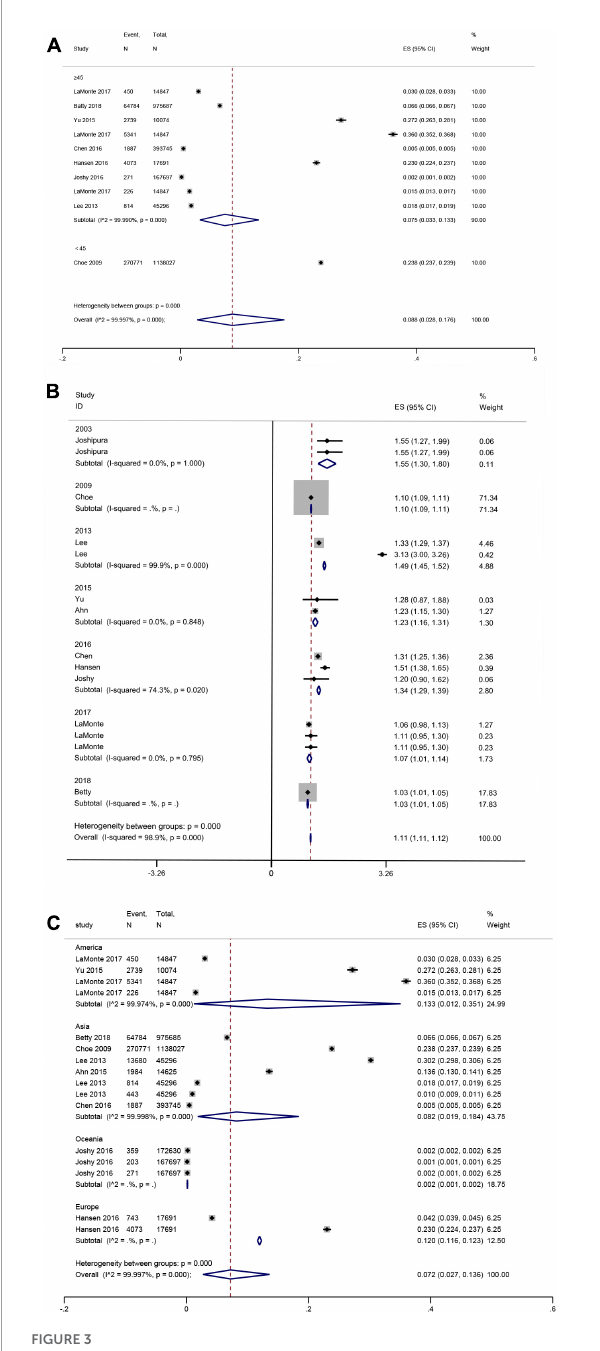
FIGURE3 Forest plot of subgroup analysis of prevalence of cardiovascular disease in patients with periodontal disease [ (A) Age, (B) Publication years, and (C) Region]. In the forest plot, the diamond indicates the pooled estimate. Red boxes are relative to study size and the black vertical lines indicate 95% CIs around the effect size